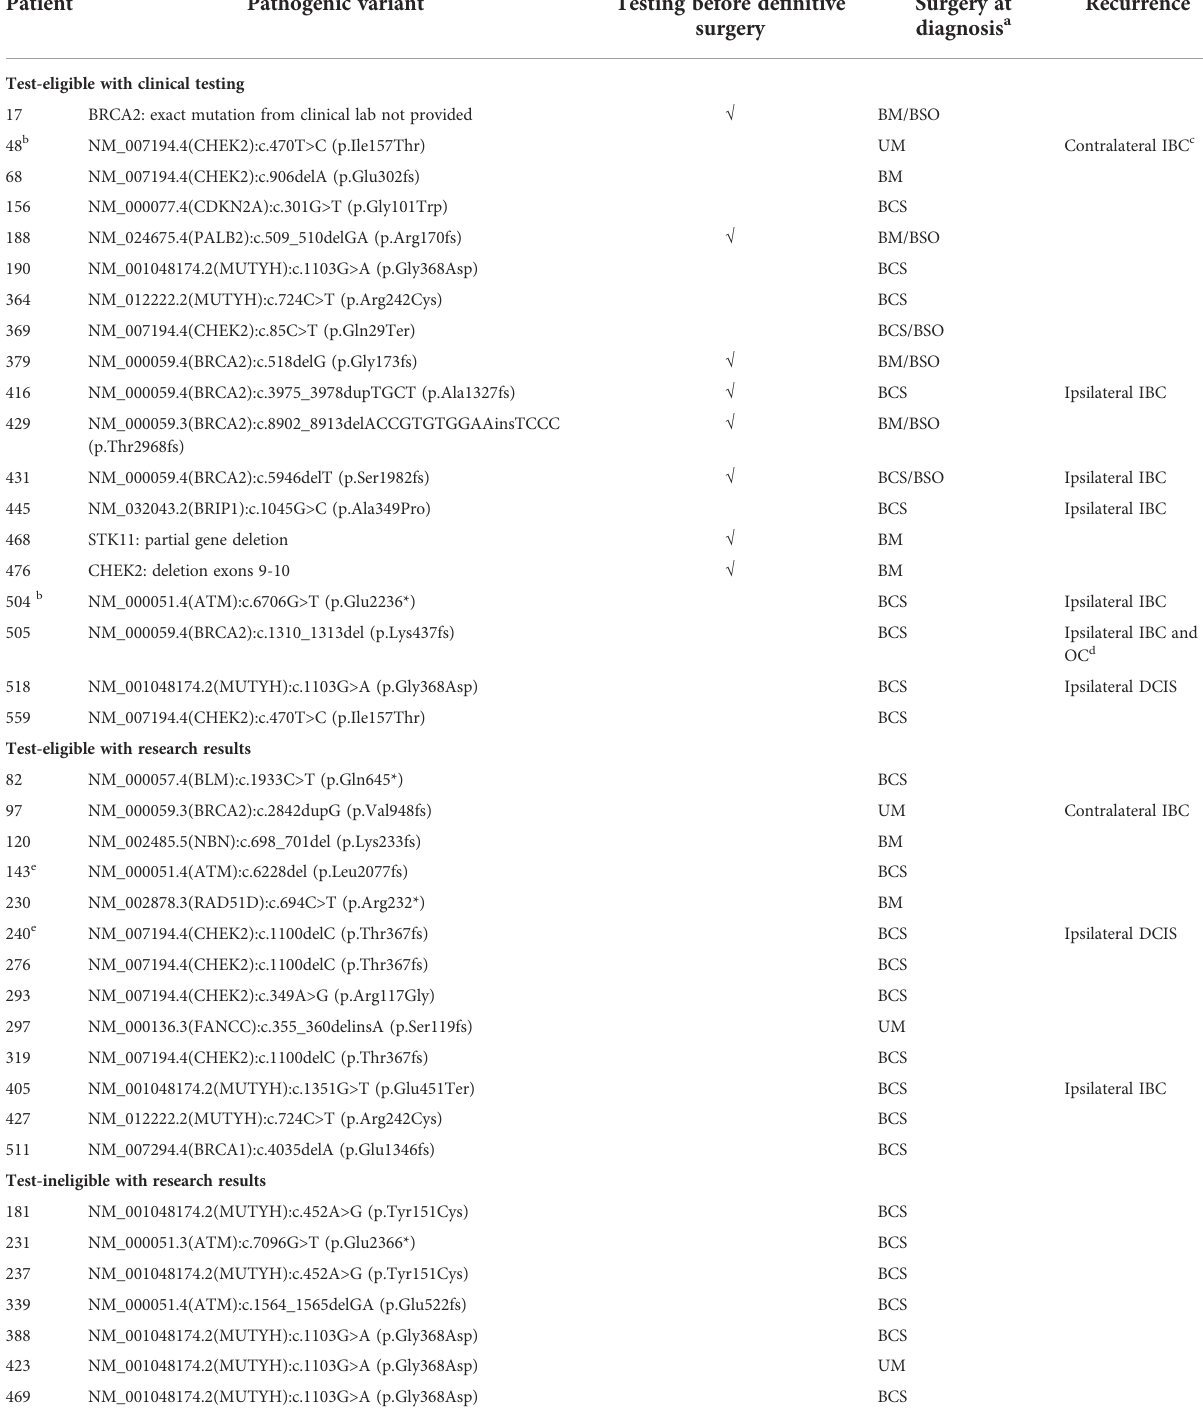
TABLE 3 Variants classi fi ed as pathogenic or likely pathogenic according to ACMG classi fi